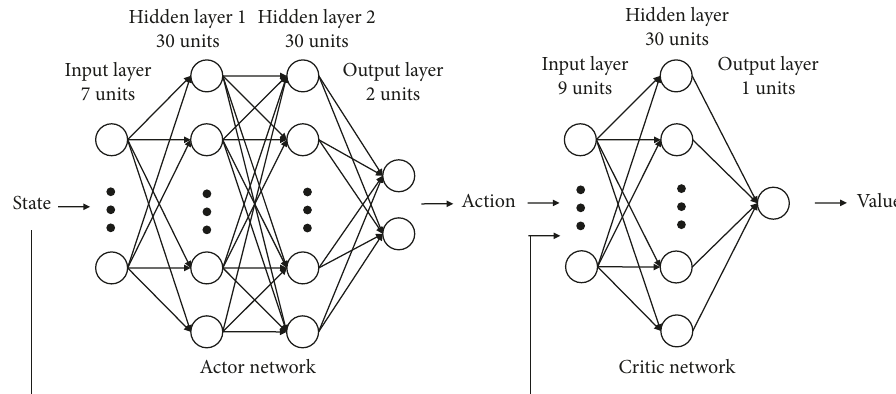
Figure 1: Actor network and critic network.